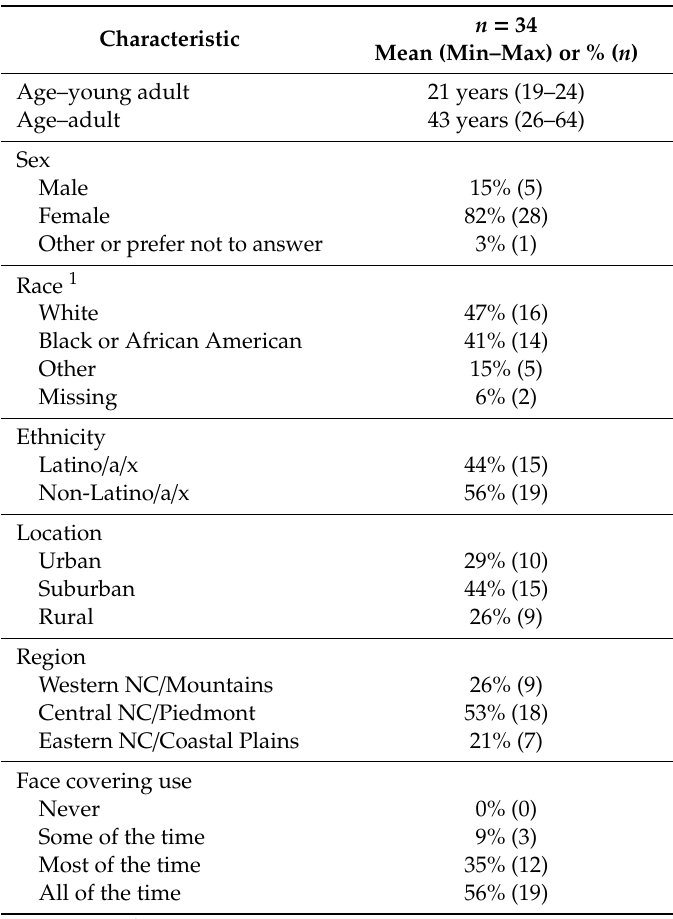
Table 1. Characteristics of focus group